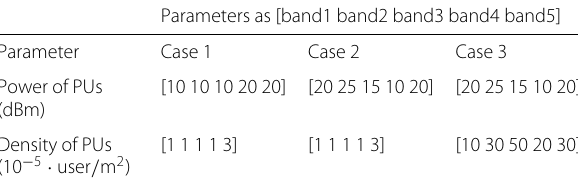
Table 2 Key parameters of the simulation on five bands